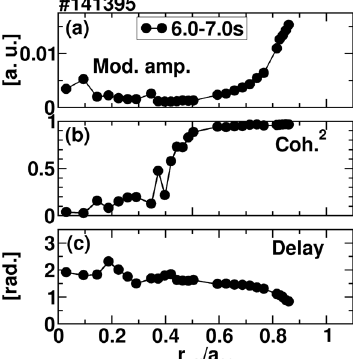
Fig.5 : Time changes of (a) input powers of the NBs, (b) input power of the modulated ECRH, (c) difference of the ECE (measured at R=4.216 m) from the time trend between 5.5 and 7.3 s, (c) difference of the stored energy from the time trend between 5.5 and 7.3 s, and (e) line averaged electron density.